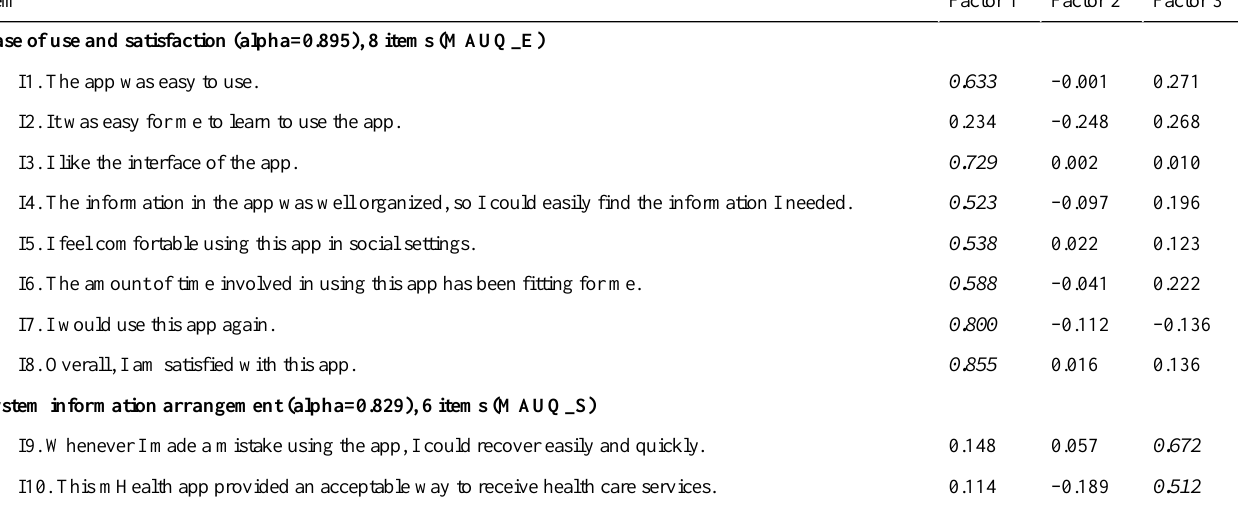
Table 2. Exploratory factor analysis results for the 21 items on the mHealth App Usability Questionnaire designed for interactive mHealth apps (overall Cronbach alpha=0.932, 21 items). Values >0.32 for each factor are italicized. Ease of use and satisfaction (alpha=0.895), 8 items